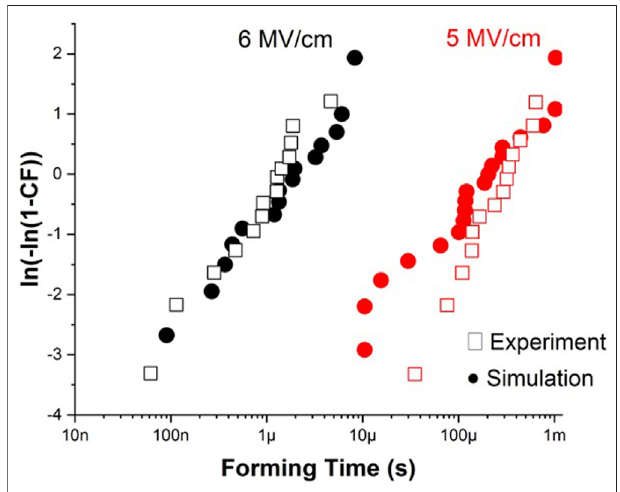
FIGURE 6 | Comparison of forming time distributions obtained from our simulations and experimental work (Lorenzi et al., 2013) for a TiN/HfO 2 /Pt device at an electric fi eld of 5 MV cm − 1 and 6 MV cm − 1